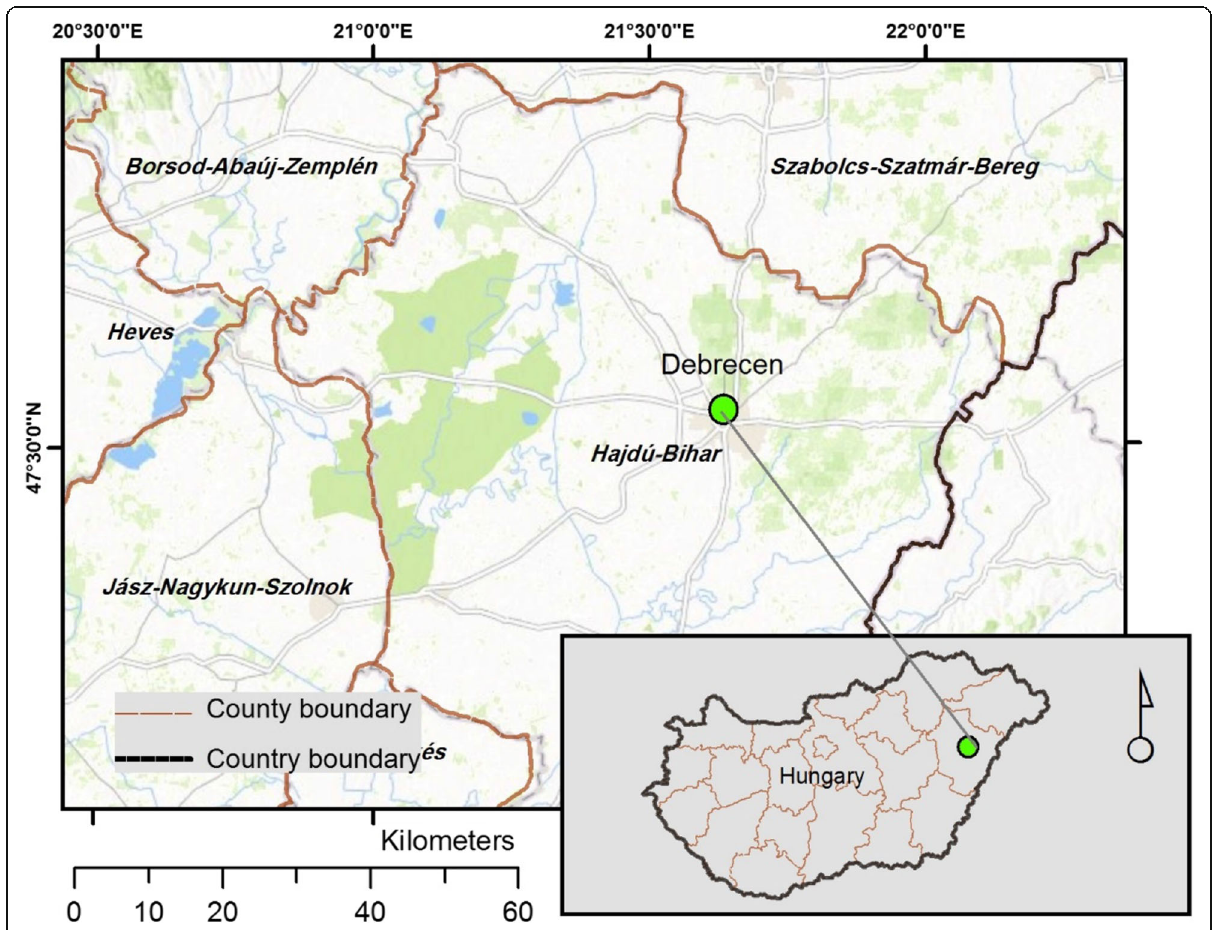
Fig. 1 Location of Debrecen Region in Hungary